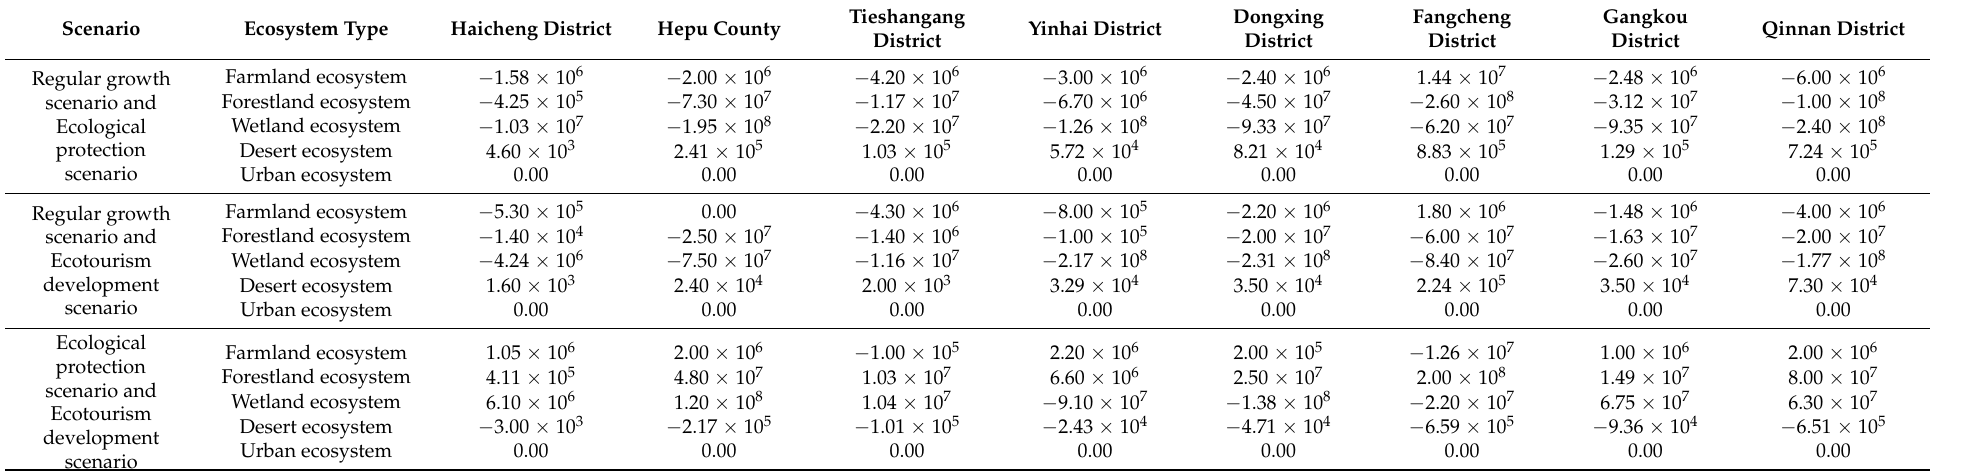
Table 9. Comparison of ecosystem service values ($) of different districts and counties for three